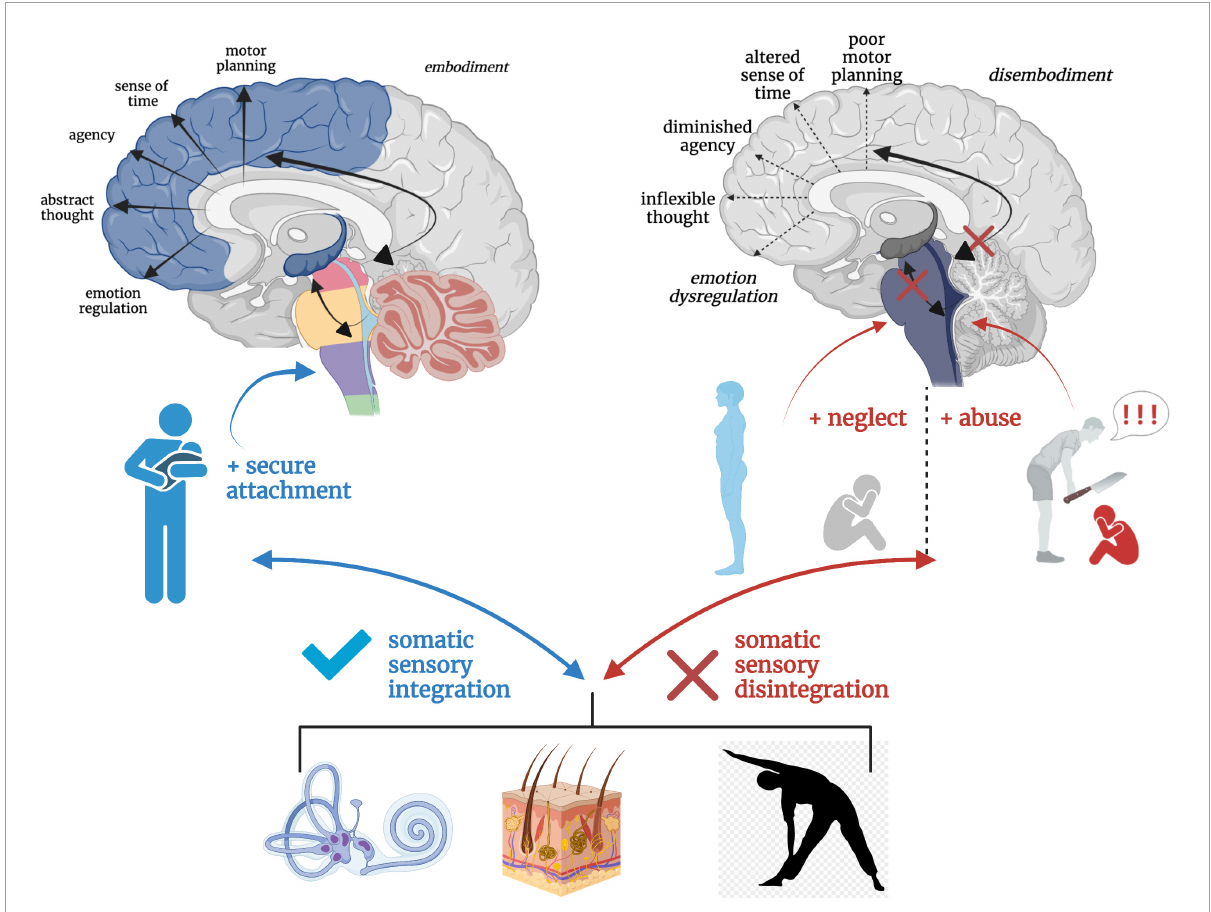
FIGURE8 A hierarchical schematic of how somatic sensory systems, mediated by early attachment patterning, provide a foundation for vertical and horizontal integration in the brain. Vestibular, tactile and proprioceptive input drive healthy neurodevelopmental processes and the development of emotion regulation, motor planning, sense of time, agency, and a sense of embodiment when scaffolded by an attuned, secure attachment figure. However, a paucity or lack of safe and nourishing somatic sensory experiences interacting with contexts of abuse and/or neglect results in overwhelmed, fragmented and disintegrated brainstem-level sensory integration, which has cascading effects on higher order capacities of limbic and cortical brain